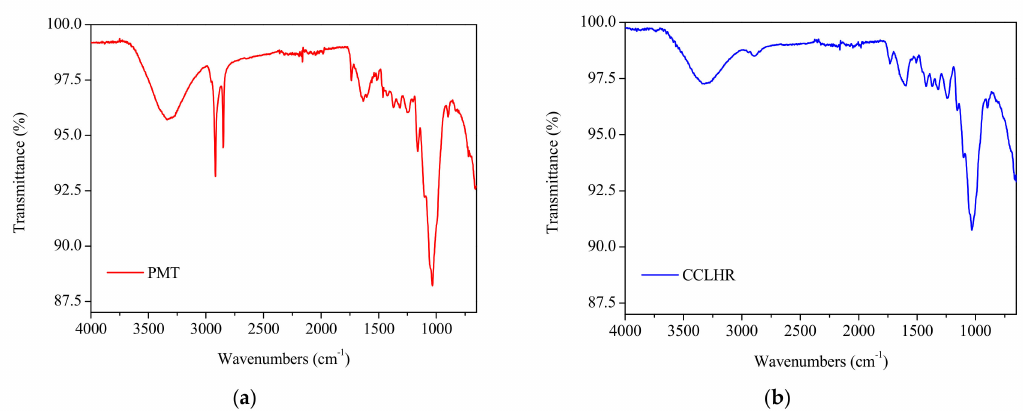
Figure 1. Infrared spectrum of Paspalum maritimum (PMT) ( a ) and CCLHR ( b ) samples, in the range of 400–4000 cm − 1 .